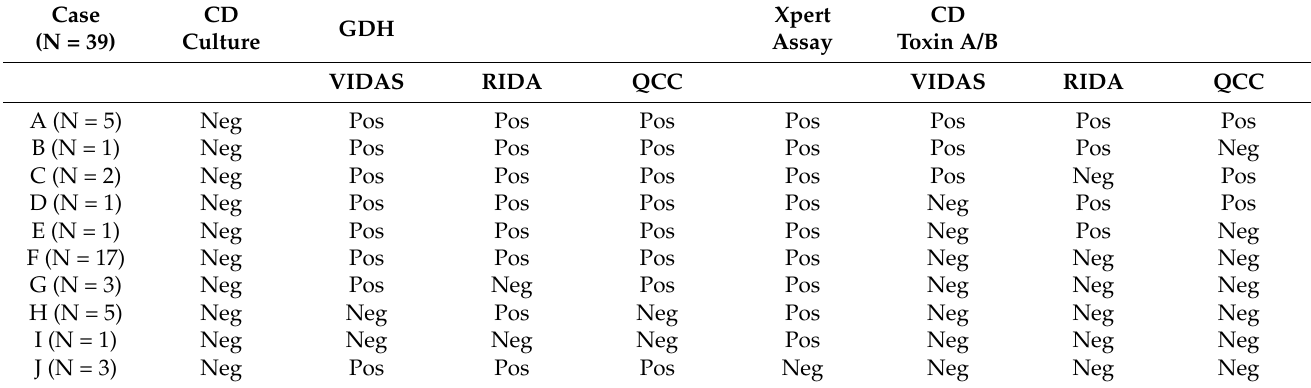
Table 5. Suspected inconclusive results interpreted by C. difficile culture and the Xpert C. difficile assay as compared to the three GDH and CD toxin A/B